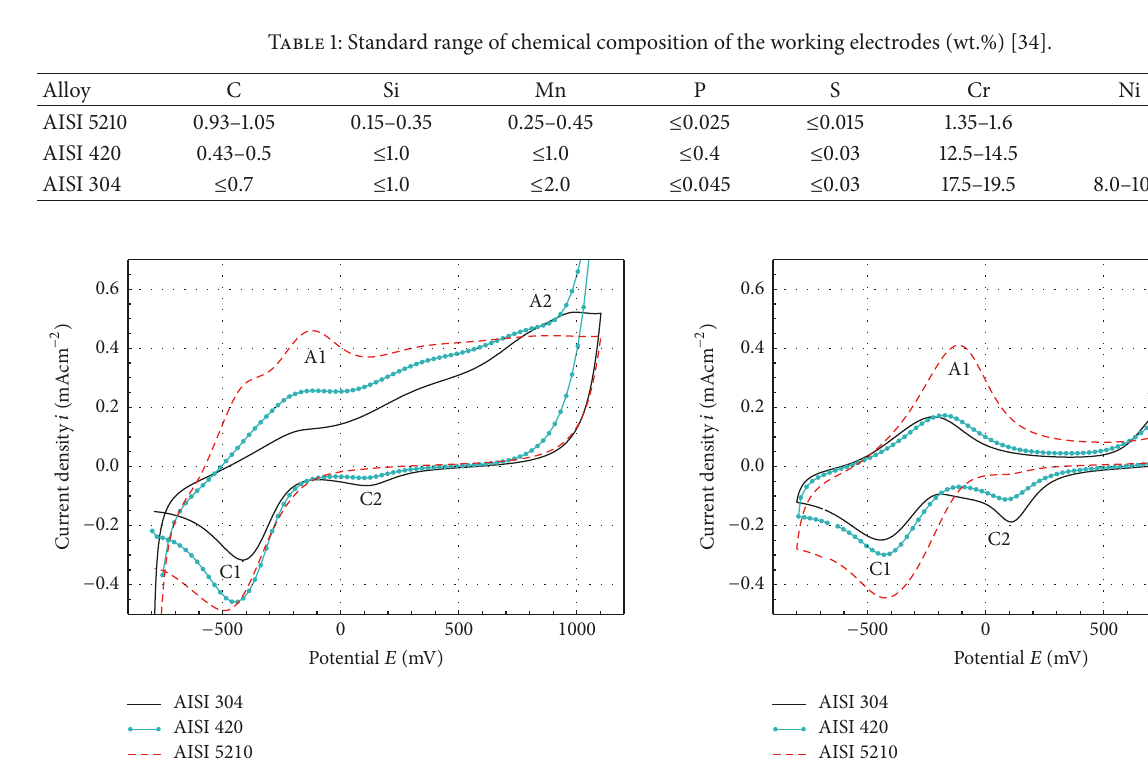
Figure 1: 1st cycle of cyclic voltammograms for AISI 5210, AISI 420, and AISI 304 recorded in phosphate buffer. The scans are recorded from − 800mV to 1100mV with a scan velocity of 100mVs −1 . All potentials are measured against the Ag/AgCl electrode.